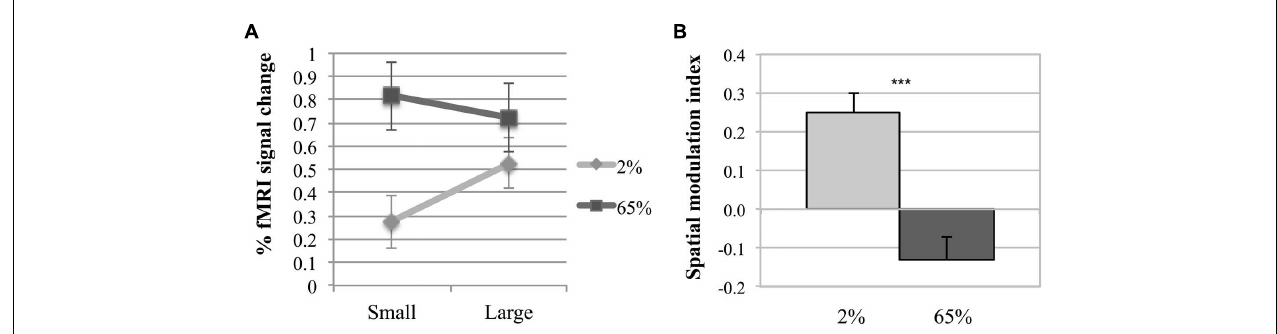
FIGURE 4 | Middle temporal activity. (A) Two-way interaction plot of the impact of size and contrast on fMRI response amplitude in MT. Error bars are 1 SE calculated across subjects. (B) Spatial Modulation Indexes (ISM). ISM is defined as the difference between fMRI response amplitudes to large and small stimuli. Asterisks indicate a statistically significant difference between the ISM-values for low and high contrasts ( ∗∗∗ p ≤ 0.001). Error bars are 1 SE calculated across